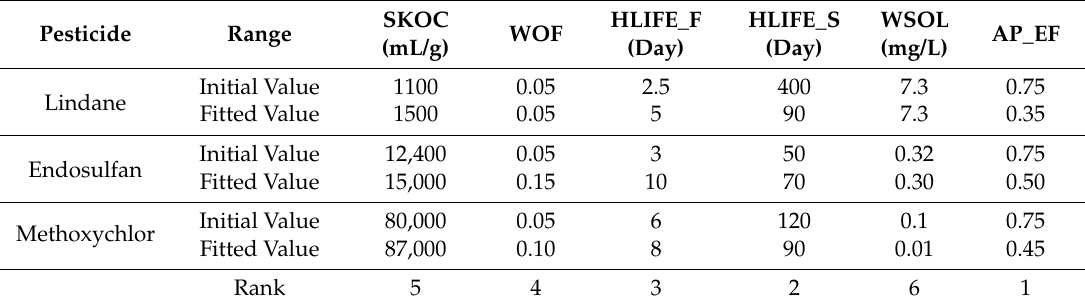
Table 4. Sensitive parameters and their ranking in simulation of pesticides residues